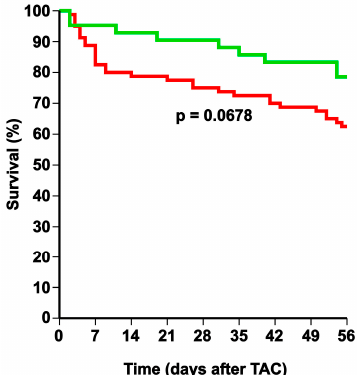
Figure 1. Comparison of Kaplan–Meier survival curves during an eight week follow-up period after transverse aortic constriction (TAC). Control TAC mice (red line) and adeno-associated viral serotype 8-human apolipoprotein A-I (AAV8-A-I) TAC mice (green line) are compared. The 0 day time-point corresponds to the induction of TAC at the age of 14 weeks. Survival analysis was performed by log-rank test.